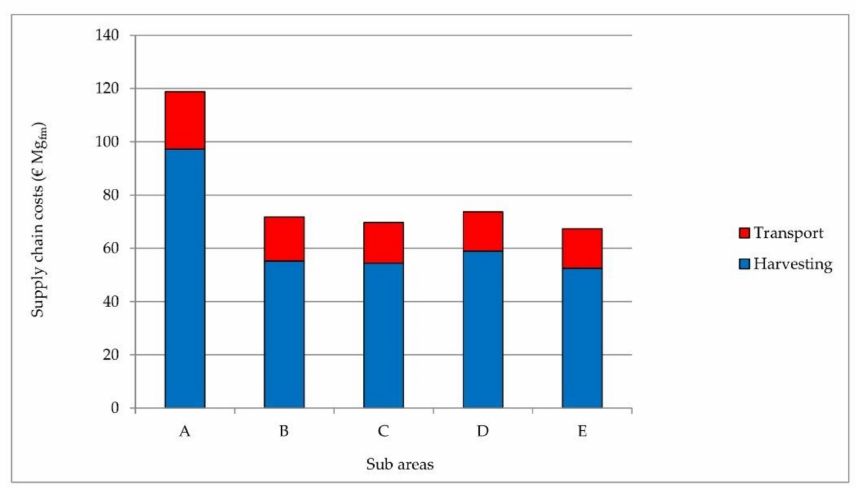
Figure 6. Supply chain costs for each suitable sub-area (harvesting, handling, loading and transport